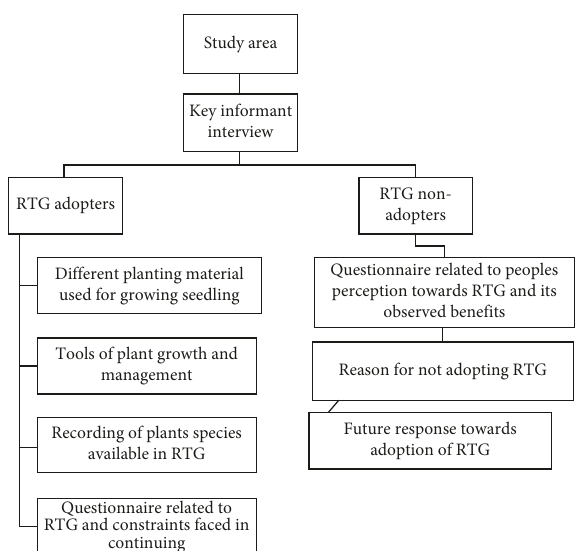
Figure 2: Method of interview and some key questions based on rooftop practitioners in the study